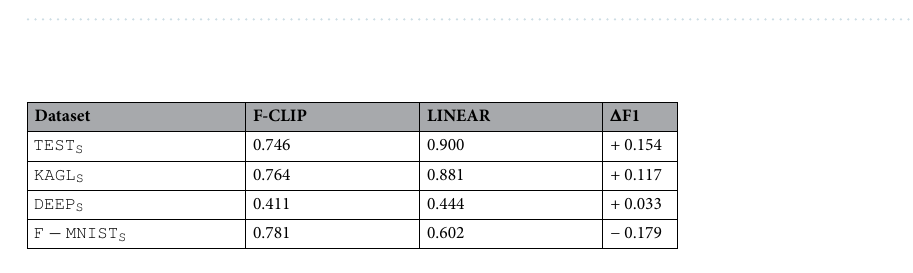
Table 3. LINEAR classification performance relative to zero-shot on F-CLIP ( F1 is weighted macro F1 ).